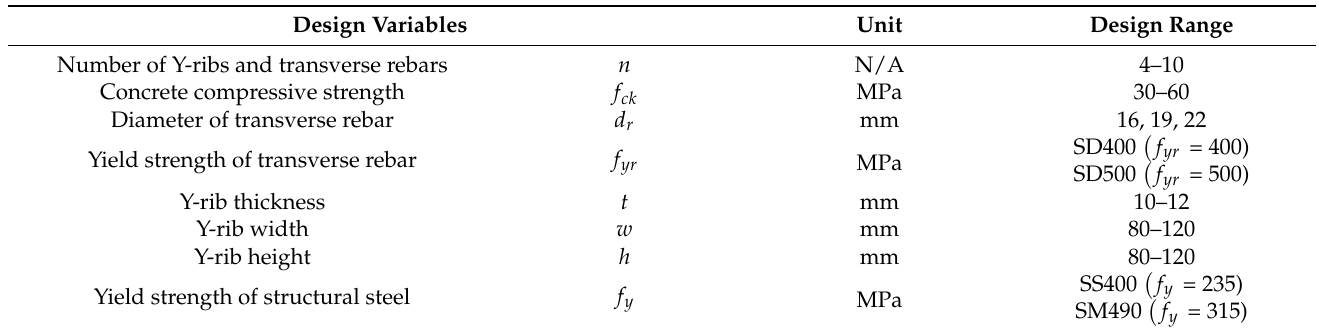
Table 7. Application ranges for design variables.